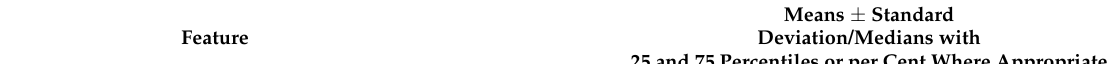
Table 1. Clinical and laboratory characteristics of all patients included in the study (N =